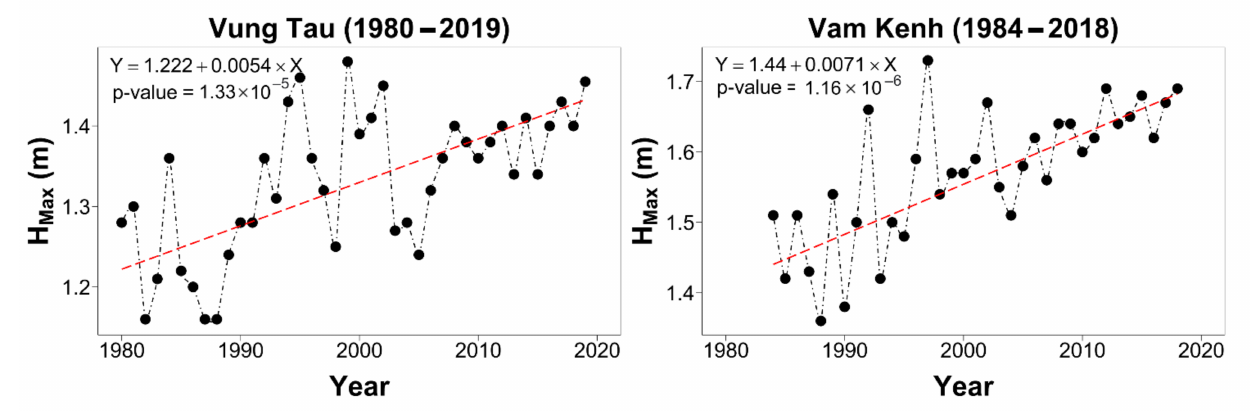
Figure 3. Annual maximum water level trends H max .